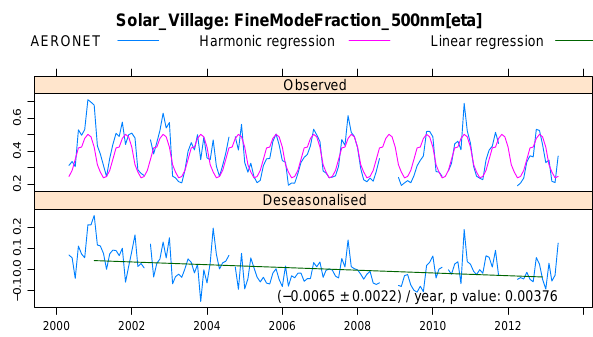
Figure 6. AERONET fine mode fraction at the station Solar Village. Deseasonalisation and trend analysis is performed as for Fig. 3; see also Figs. S37 and S38 in the